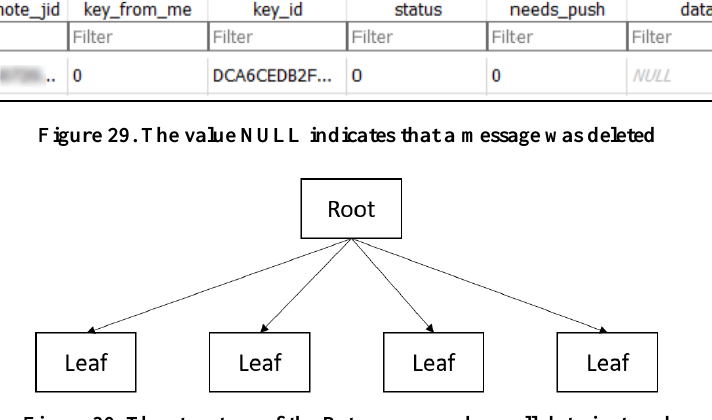
Figure 30. The structure of the B-tree pages where all data is stored